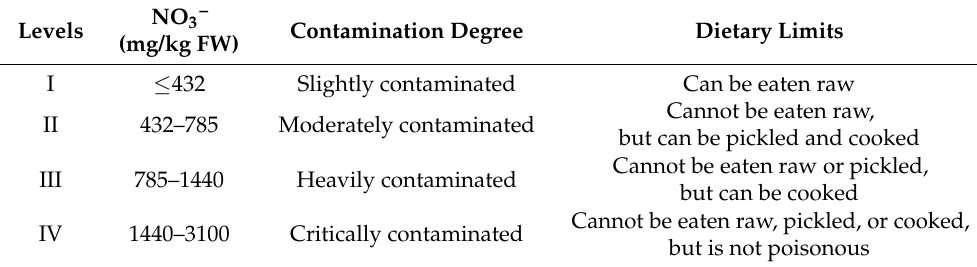
Table 2. The classification of nitrate accumulation in fresh